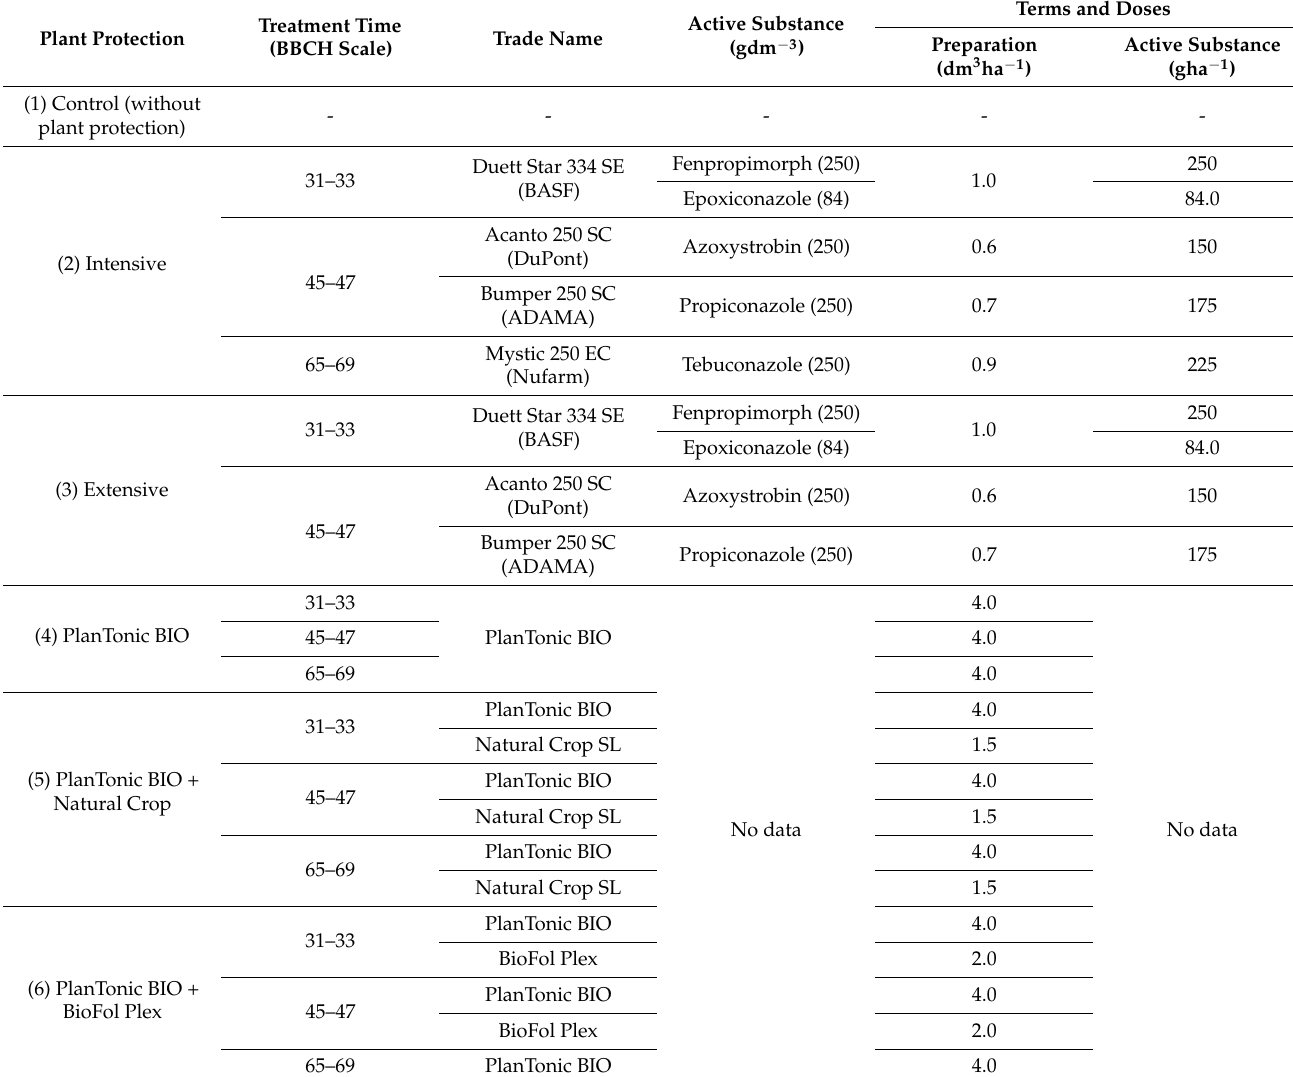
Table 1. Conventional plant protection products and biostimulants used in the cultivation of winter wheat—doses and dates of